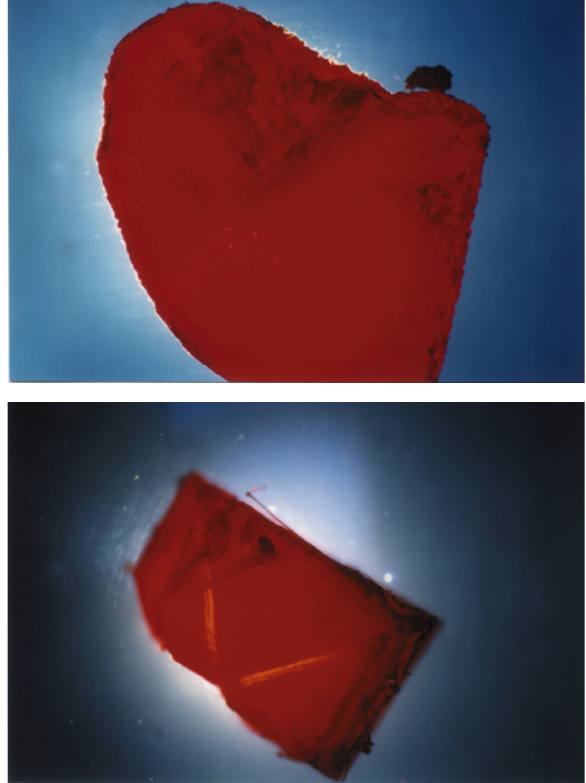
Figure 2. Optical microscopy images (1.0 x 1.5 cm 2 ) by transmitted un-polarized light along the [0 0 1] direction of a (0 0 1) face of platelets grown with source material sublimating at 126 °C, 6 days of growing time in the F2 furnace configuration and with ceramic wool as insulator: a) example of irregular shape but constant thickness platelet and b) example of right angled but irregular thickness platelet.